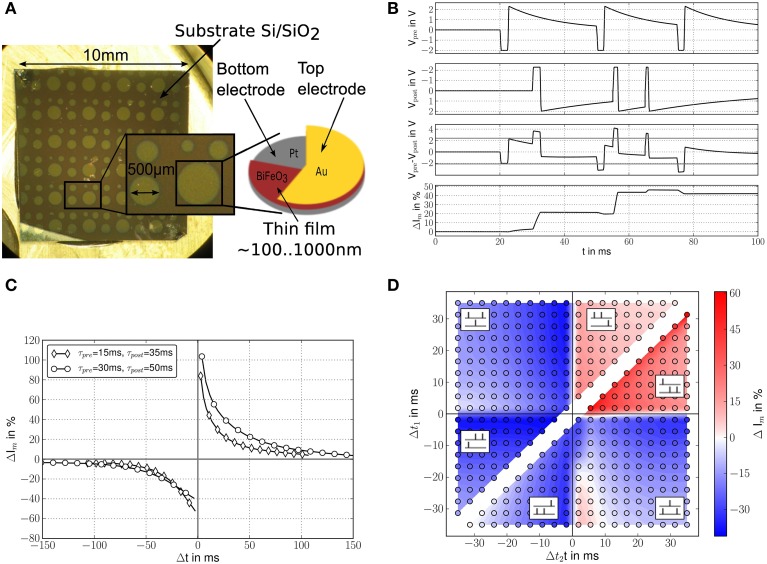
(A) Layout/processing of BiFeO3 devices used (Shuai et al., 2013); (B) driving voltage waveforms (from top to bottom): pre-synaptic waveform, post-synaptic waveform, resulting differential voltage across memristor and resulting memristance change shown as percentage change in current through the memristor for a fixed 2 V measurement voltage (Cederstroem et al., 2013); (C) measured STDP curves for two different STDP time window settings; time windows are adjusted via the time constants of the exponentials slopes of pre- and post-synaptic waveform, which changes the LTP respectively the LTD part of the STDP window; Weight change as change in current through the memristor; (D) measured spike triplet curves (Froemke and Dan, 2002), weight change as change in current through the memristor (Mayr et al., 2012).